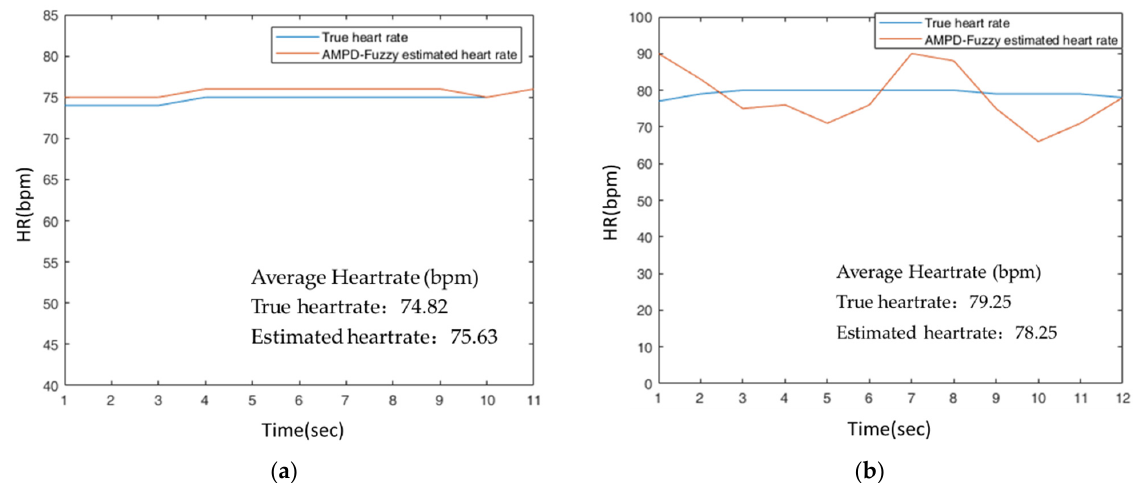
Figure 26. ( a ) Estimated heart rate on the finger with AMPD-Fuzzy; ( b ) Estimated heart rate on the dynamic wrist with